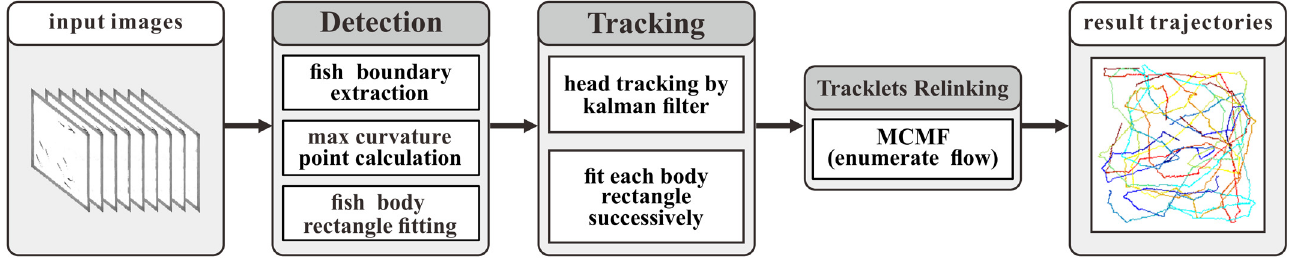
Fig 1. System workflow. The proposed tracking system has three main stages, namely fish detection, fish tracking and tracklets relinking. The first two stages are repeated until all the images have been processed. Tracklets relinking is a postprocessing stage which further solves trajectory fragmentation caused by occlusion and detection